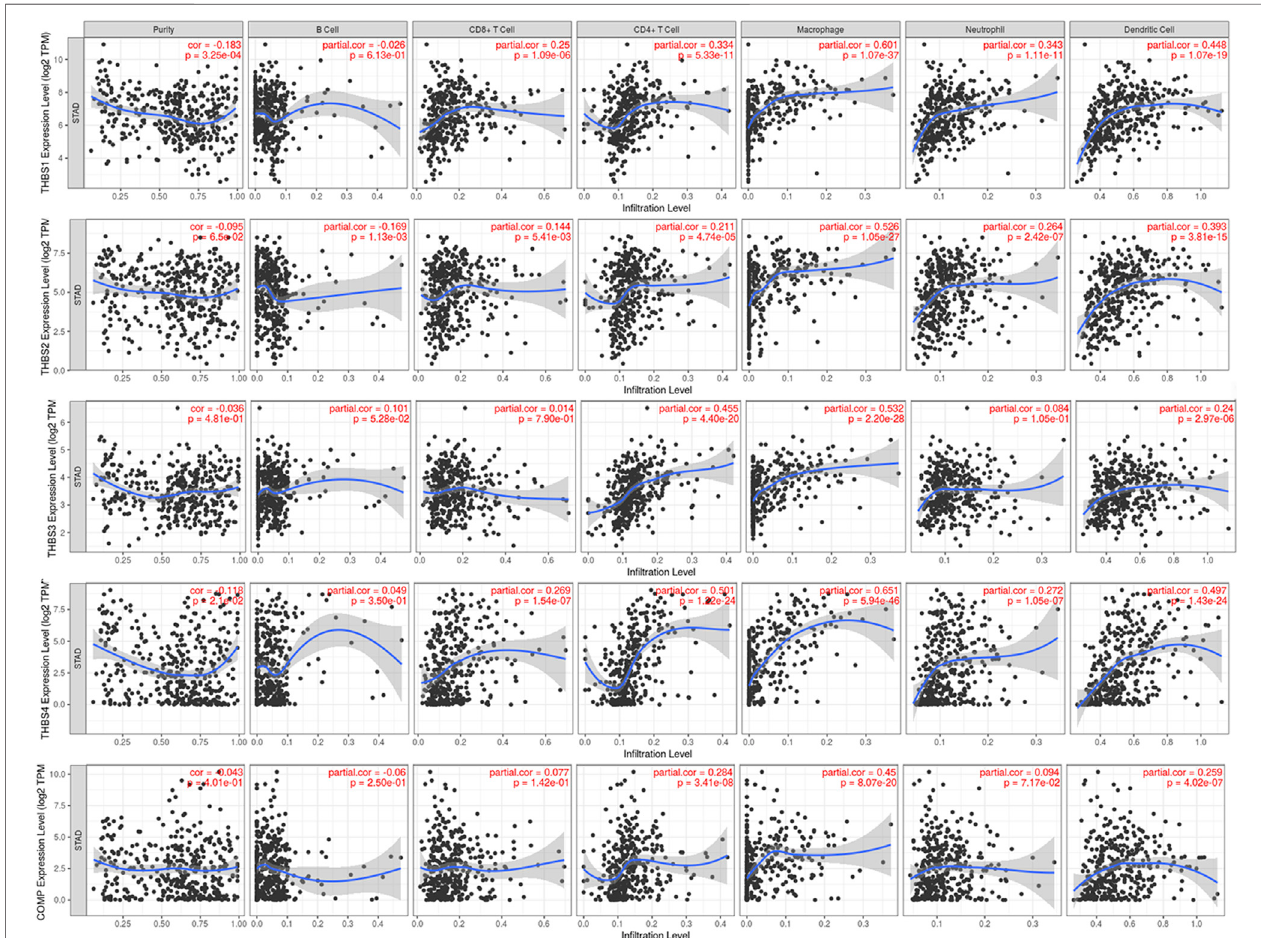
FIGURE 7 | Correlations between THBSs expression and tumor purity and dominant immune cells in fi ltration levels (TIMER).